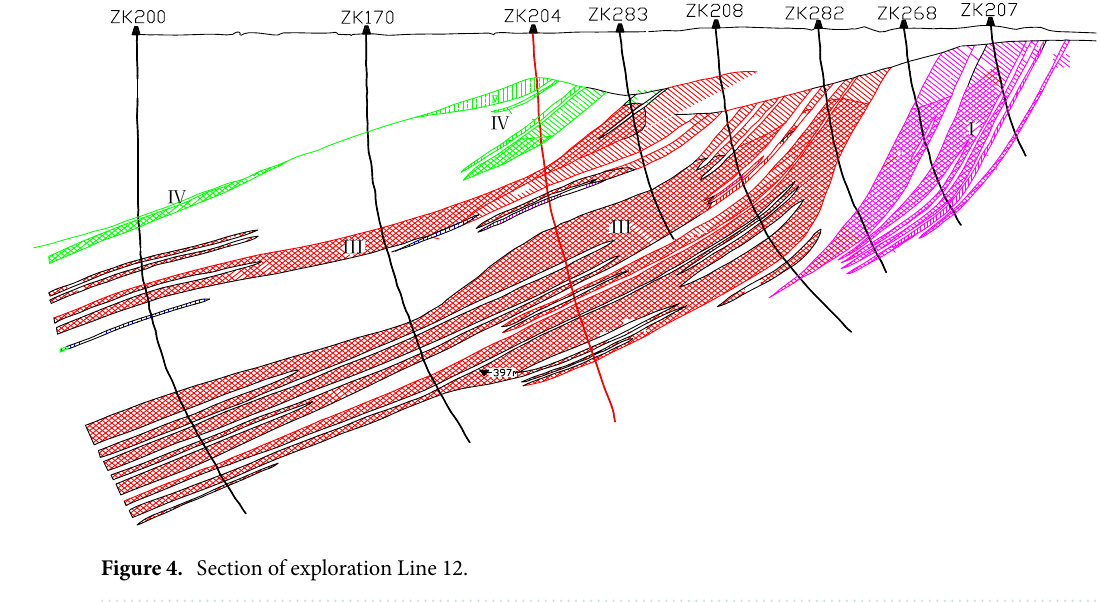
Figure 4. Section of exploration Line 12.